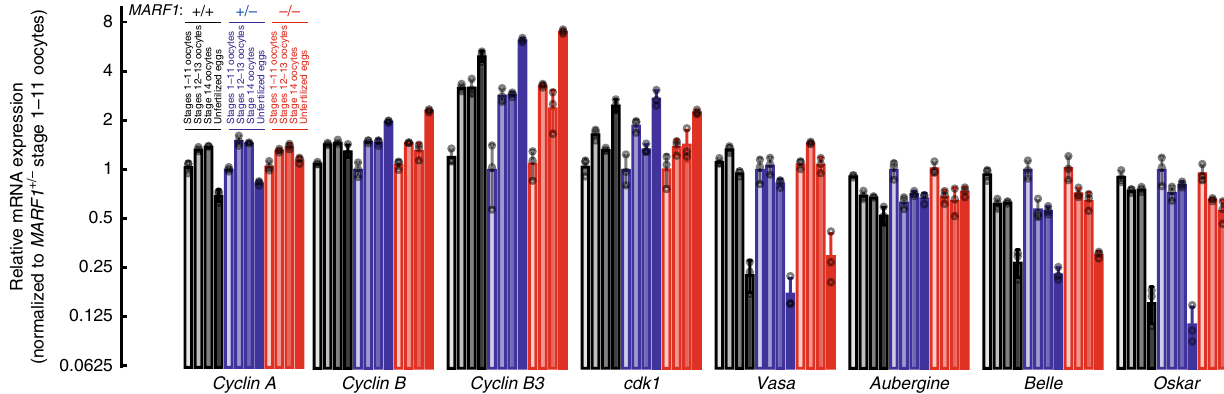
Fig. 6 Cyclin mRNA levels are unchanged in MARF1 null stage 14 oocytes. mRNA levels relative to MARF1 null/ + stages 1 – 11 oocytes determined by